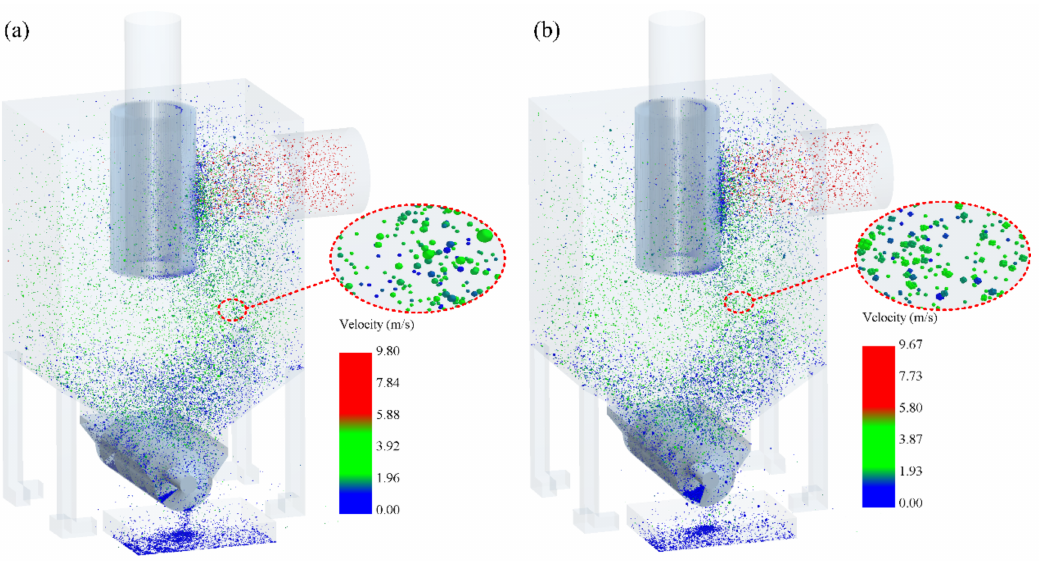
Figure 11. Snapshots of the screening process in DEM simulations: ( a ) spherical particles and ( b ) non-spherical particles.